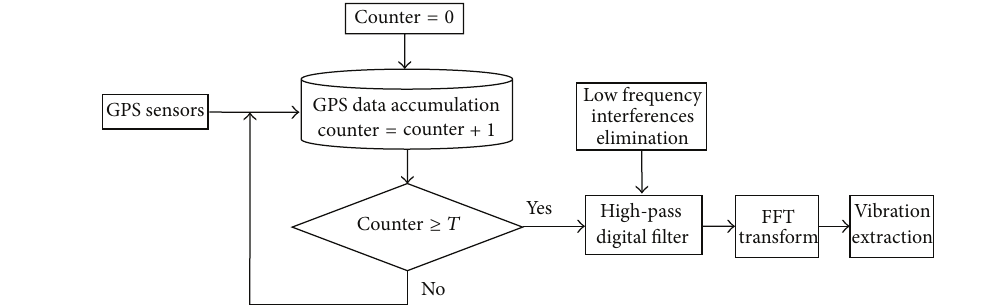
Figure 5: Flowchart for vibration frequencies extraction for the Forth Road Bridge.